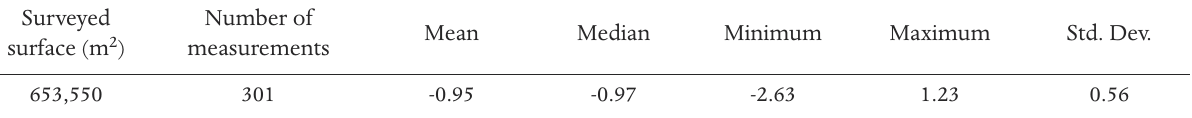
Table 3. Surveyed surface (in m 2 ), number of measurements and statistical parameters (mean, median, minimum, maximum and standard deviation) of the ϕ CO , expressed as ln( ϕ CO ) (mol m -2 day -1 ). 2 2